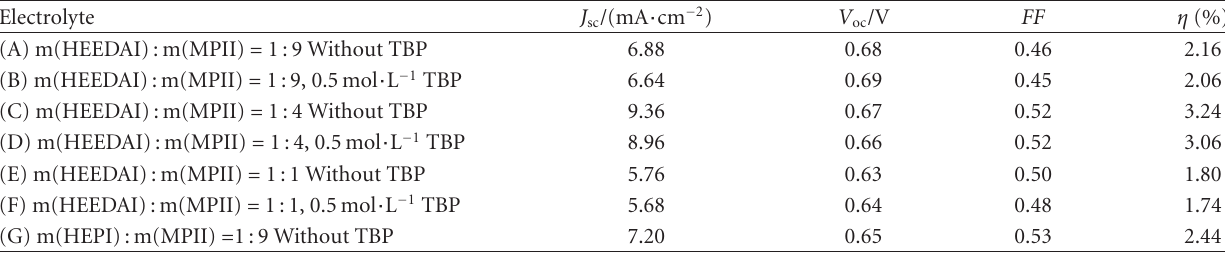
Table 3: Photovoltaic performance of DSCs with electrolytes A ∼ G.